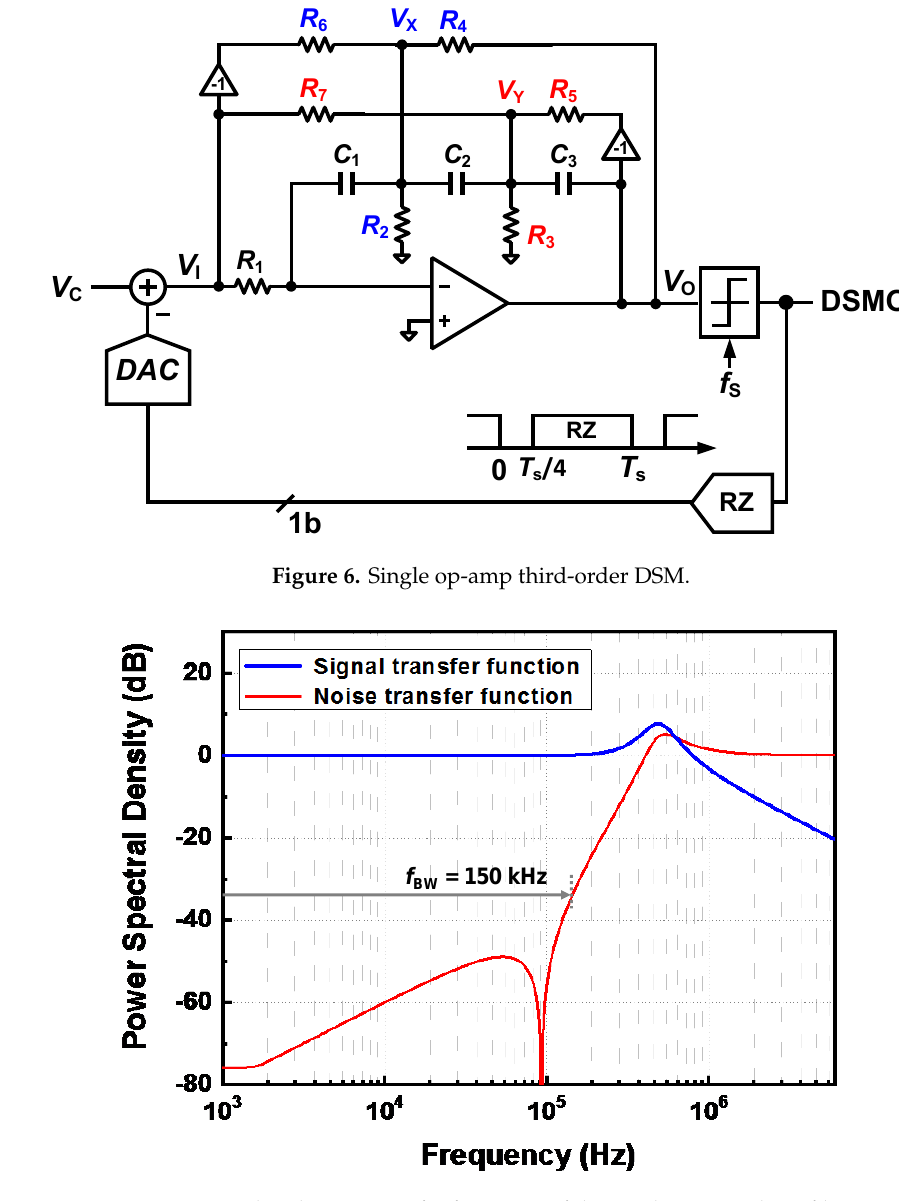
Figure 7. Signal and noise transfer functions of the single op-amp loop filter.